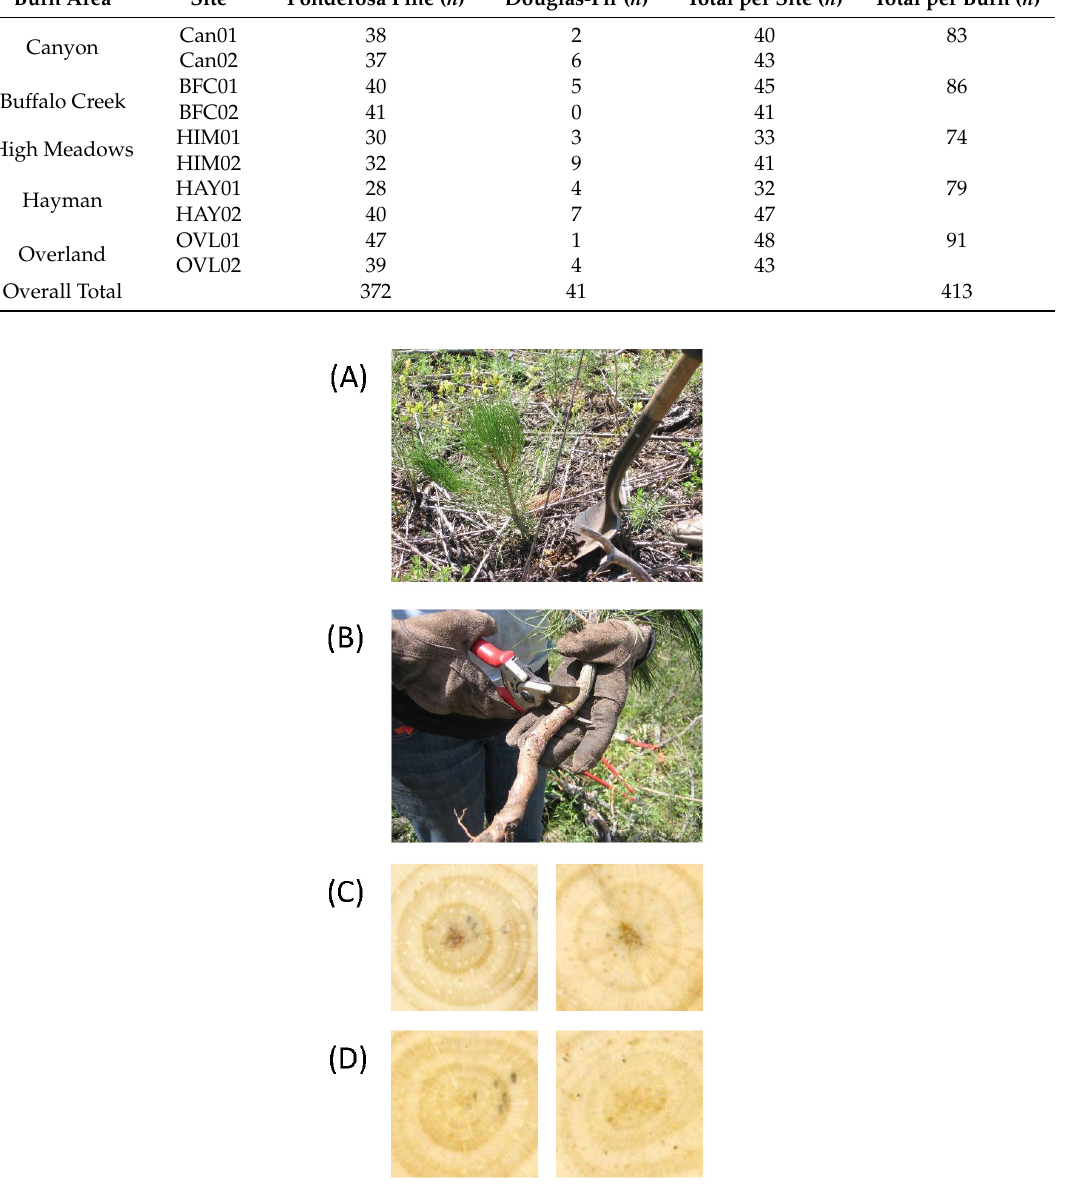
Figure 2. Images from the field and laboratory related to methods for dating juvenile trees in the present study. ( A ) A post ‐ fire ponderosa pine seedling being harvested from a burn area; ( B ) collecting a subsample from the harvested seedling; ( C ) images from the stem portion of a sample, with the piths visible; ( D ) images from the root portion of a sample, with the pith no longer